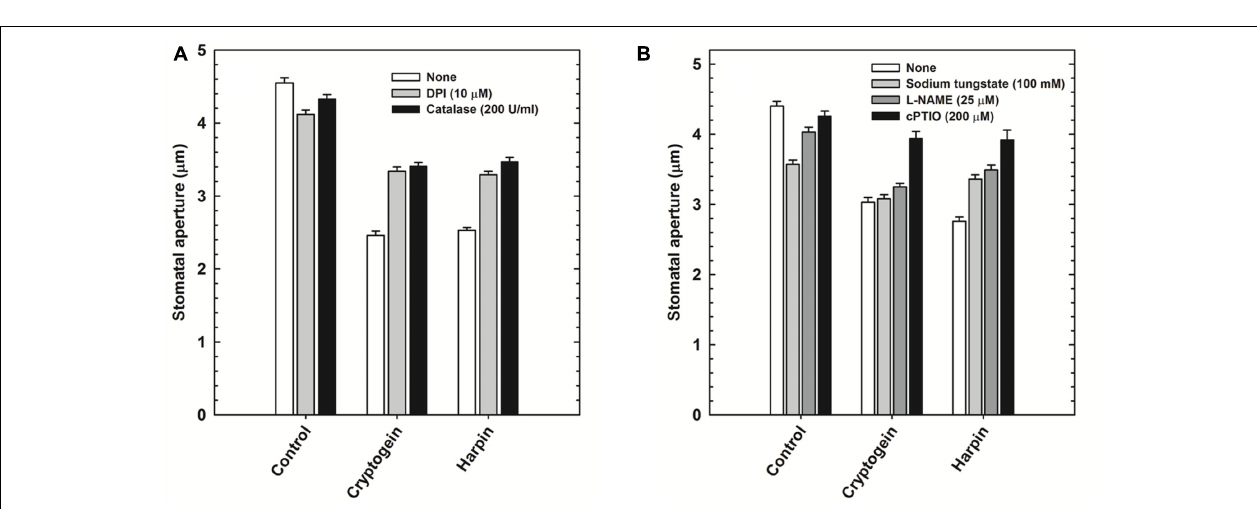
FIGURE 4 | Effect of ROS or NO modulators on stomatal closure by cryptogein and harpin. ROS modulators 10 µ M DPI (NADPH oxidase inhibitor) and 200 U/ml catalase (ROS scavenger) relieved the effect of two microbial elicitors, partially (A) . Cryptogein and harpin showed the effect on stomatal closure, in the absence